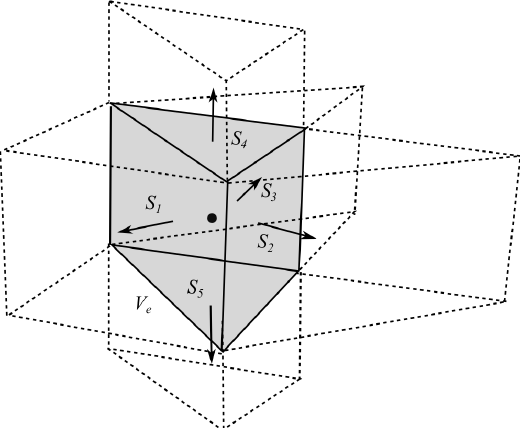
Figure 4. Schematic plot of the control volume prism V e formed by an unstructured triangular grid in the horizontal and several layers in the vertical direction of the system ( x ∗ , y ∗ , σ ) . The five faces are denoted as S j ( j = 1, . . .